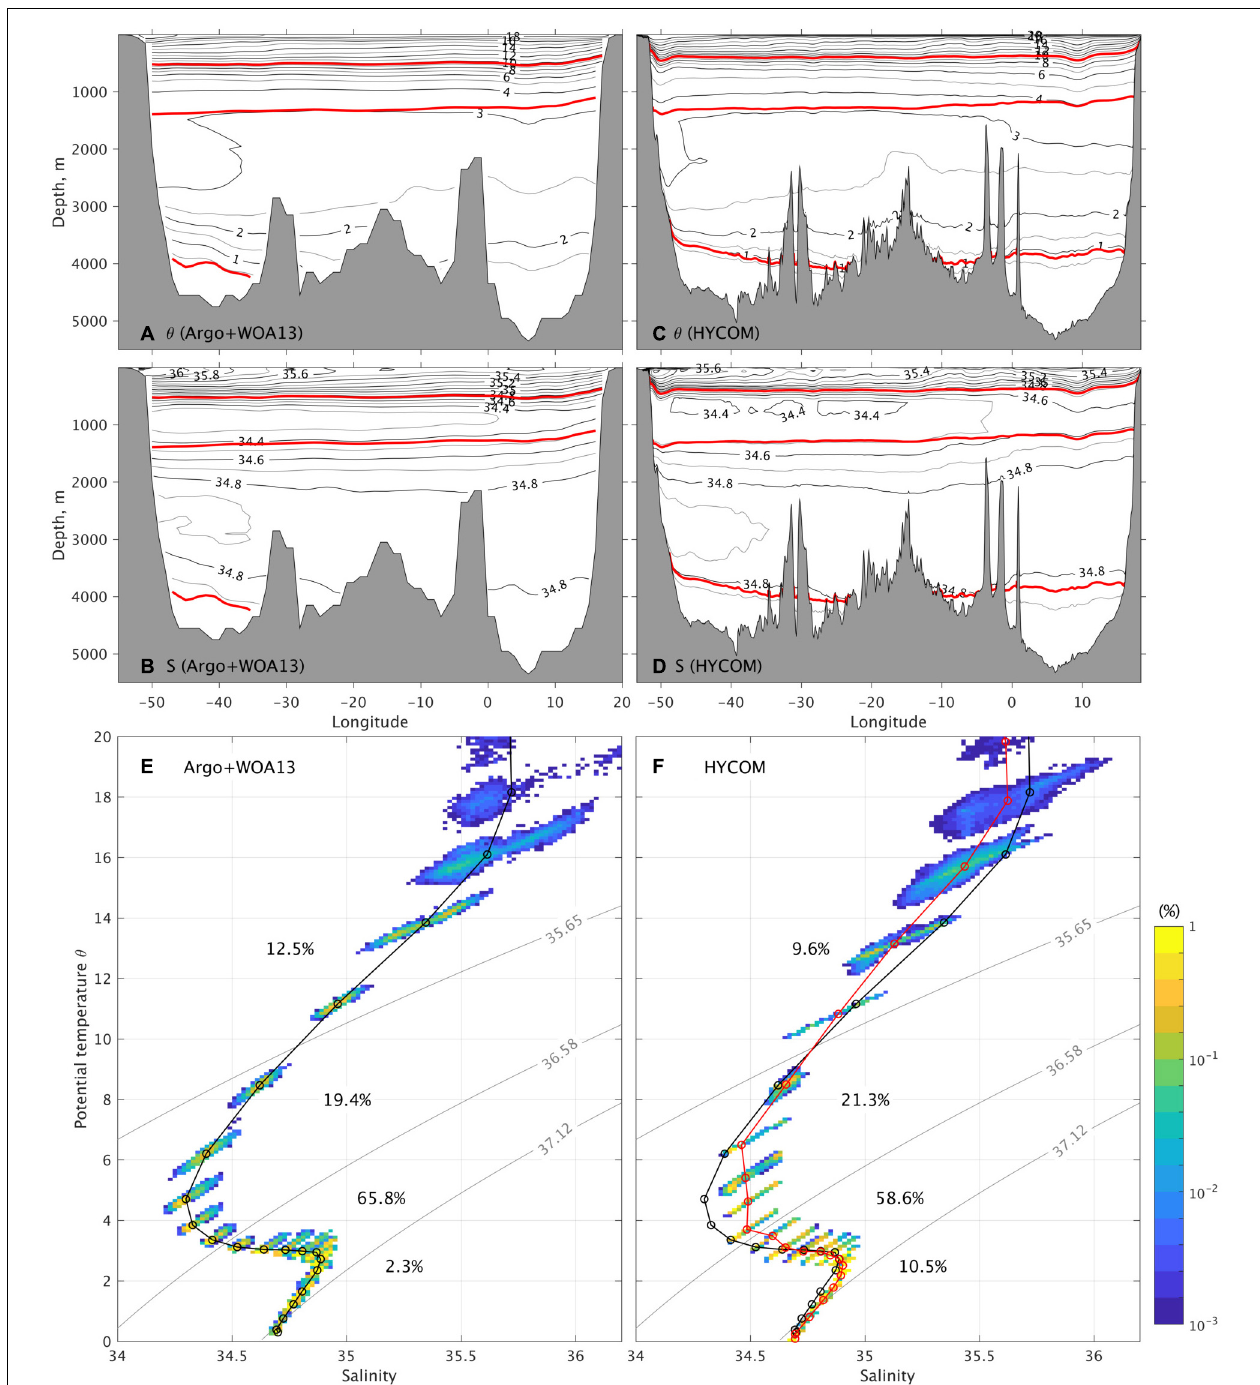
FIGURE 3 | (A–D) Potential temperature θ and salinity S distributions across 34 ◦ S. Observations are based on a combination of Argo profiles for the top 2000 m and World Ocean Atlas 2013 (WOA13) below 2000 m; model results are from the global 1/12 ◦ HYCOM simulation. Three red lines denote isopycnic surfaces ( σ 2 of 35.65, 36.58, and 37.12 kg m − 3 ) that divide the water column into near surface water, Antarctic Intermediate Water (AAIW), North Atlantic Deep Water (NADW), and Antarctic Bottom Water (AABW). (E,F) Volumetric θ -S diagram along 34 ◦ S. Color shading shows the volume percentage for water mass with (cid:49) θ , (cid:49) S resolution of 0.1 ◦ C, 0.02 psu (percentages for near surface water, AAIW, NADW and AABW are also listed); circled lines are volume-weighted θ -S profile in observations (black) and model results